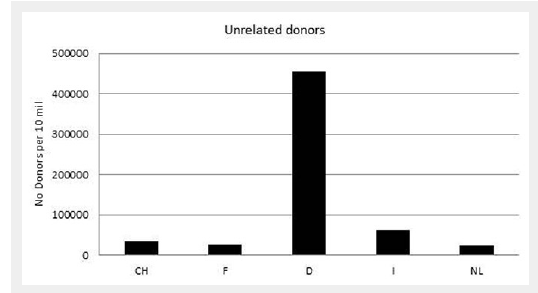
Allogeneic HSCT rates per 10 million inhabitants per year. 1a: all allogeneic HSCT. 1b: allogeneic HSCT from a family donor. 1c: allogeneic HSCT from an unrelated donor (CH: Switzerland, F: France, D: Germany, I: Italy, NL: the